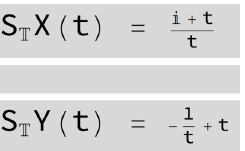
Figure 14. Output given by the [SInt] algorithm.